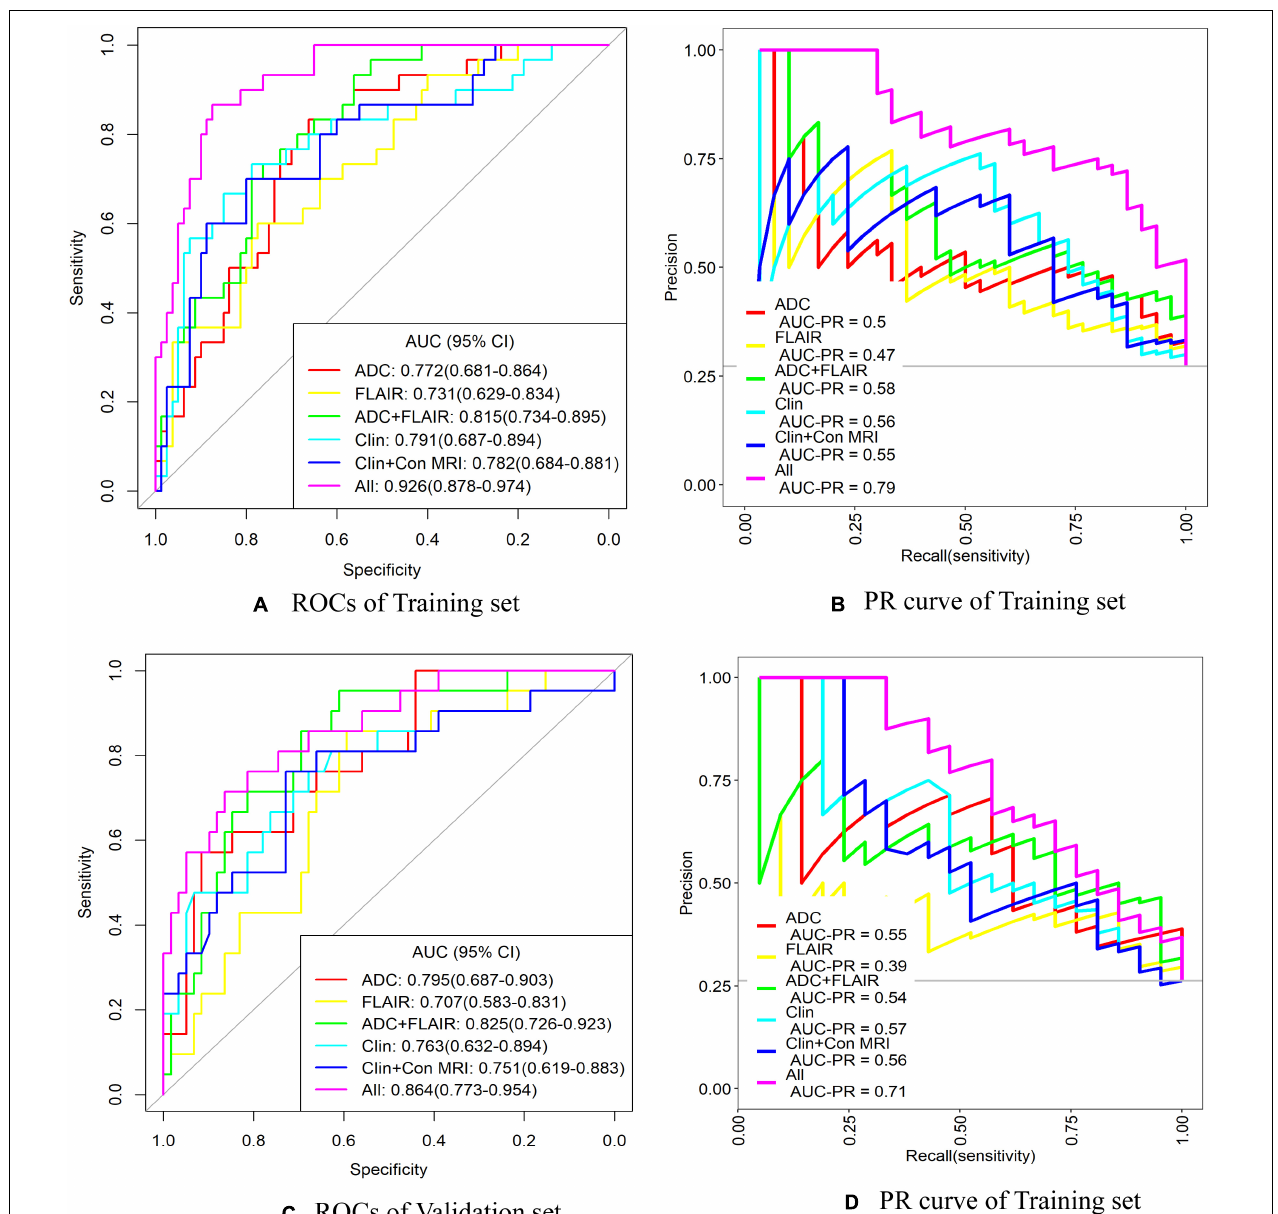
FIGURE 5 | ROC and precision–recall (PR) curve analysis of the six models for predicting unfavorable outcome in training and validation sets. ADC, apparent diffusion coefficient; AUC, area under the curve; Clin + Con MRI, clinical + conventional MRI variables; CI, confidence interval; FLAIR, fluid-attenuated inversion recovery; ROC, receiver operating characteristic curve. (A,B) ROC and PR curves of the training set. (C,D) ROC and PR curves of the validation